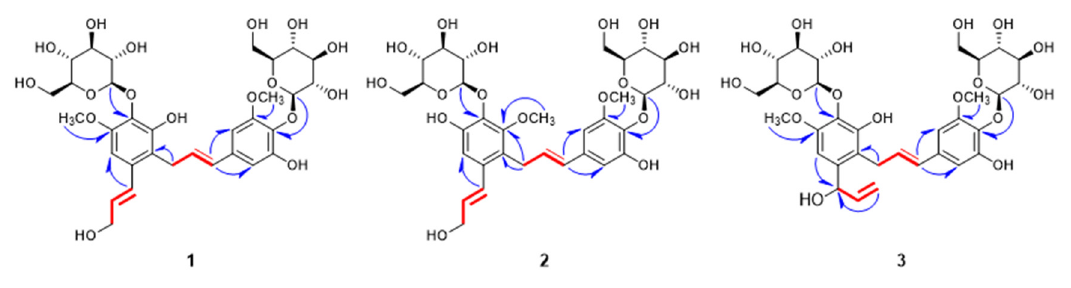
Figure 2. Key 1 H- 1 H COSY ( Figure 2. Key 1 H- 1 H COSY ( ▬ ) and HMBC ( ) correlations of compounds 1 – 3. Figure 2. Key 1 H- 1 H COSY ( ▬ ) and HMBC ( ) correlations of compounds 1 – Figure 2. Key 1 H- 1 H COSY ( ▬ ) and HMBC ( ) correlations of compounds 1 – 3.